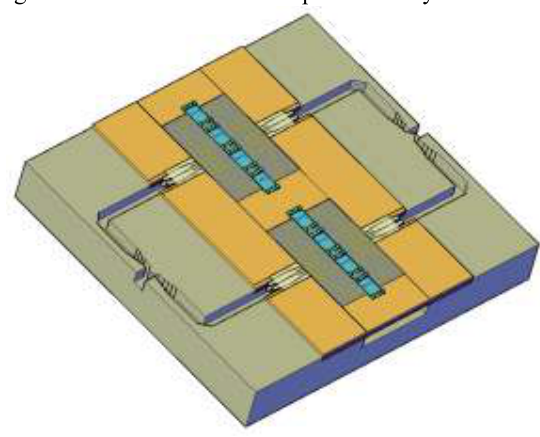
Figure 8: The complete Ka-Band SPC Amplifier: top cover removed for simplicity of